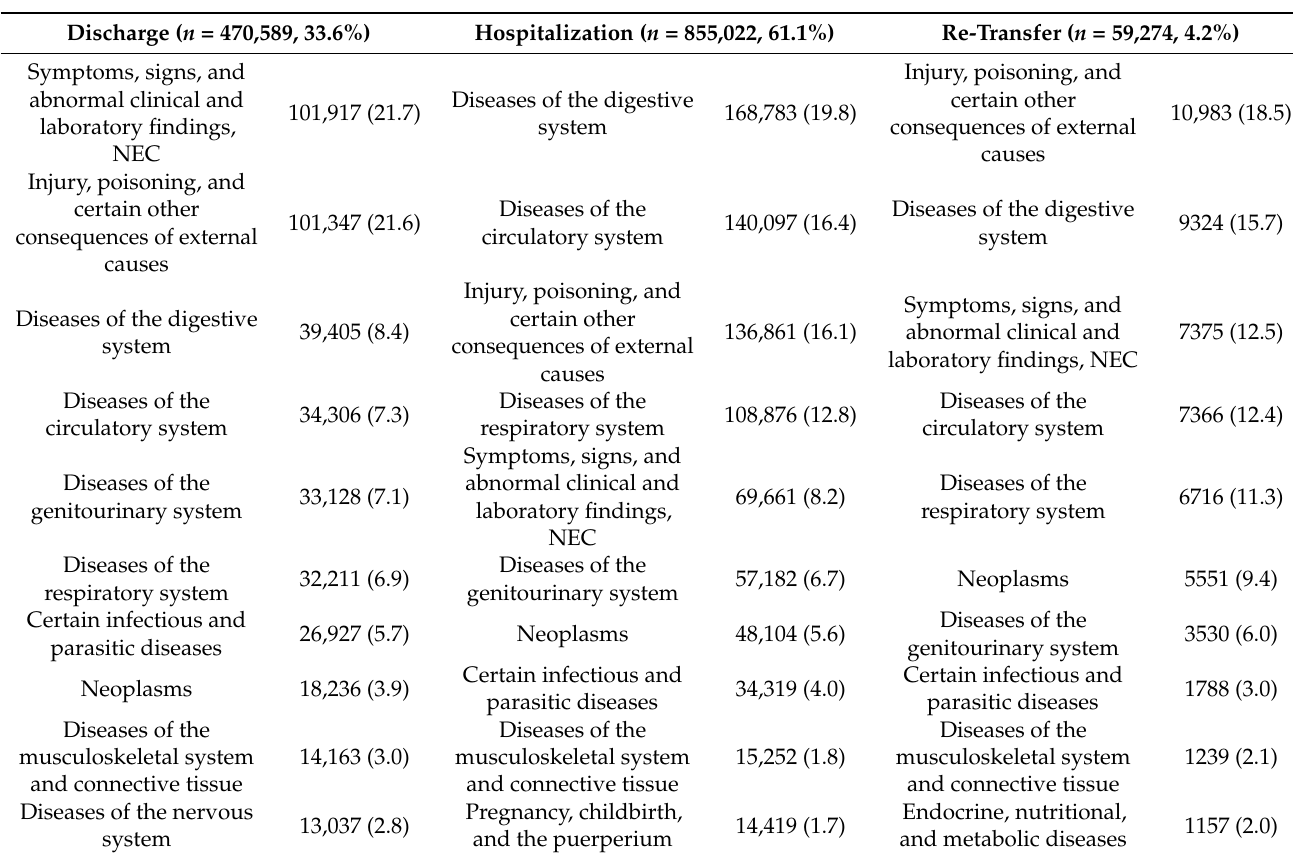
Table 3. Top 10 disease classifications based on patient dispositions in referred visits.